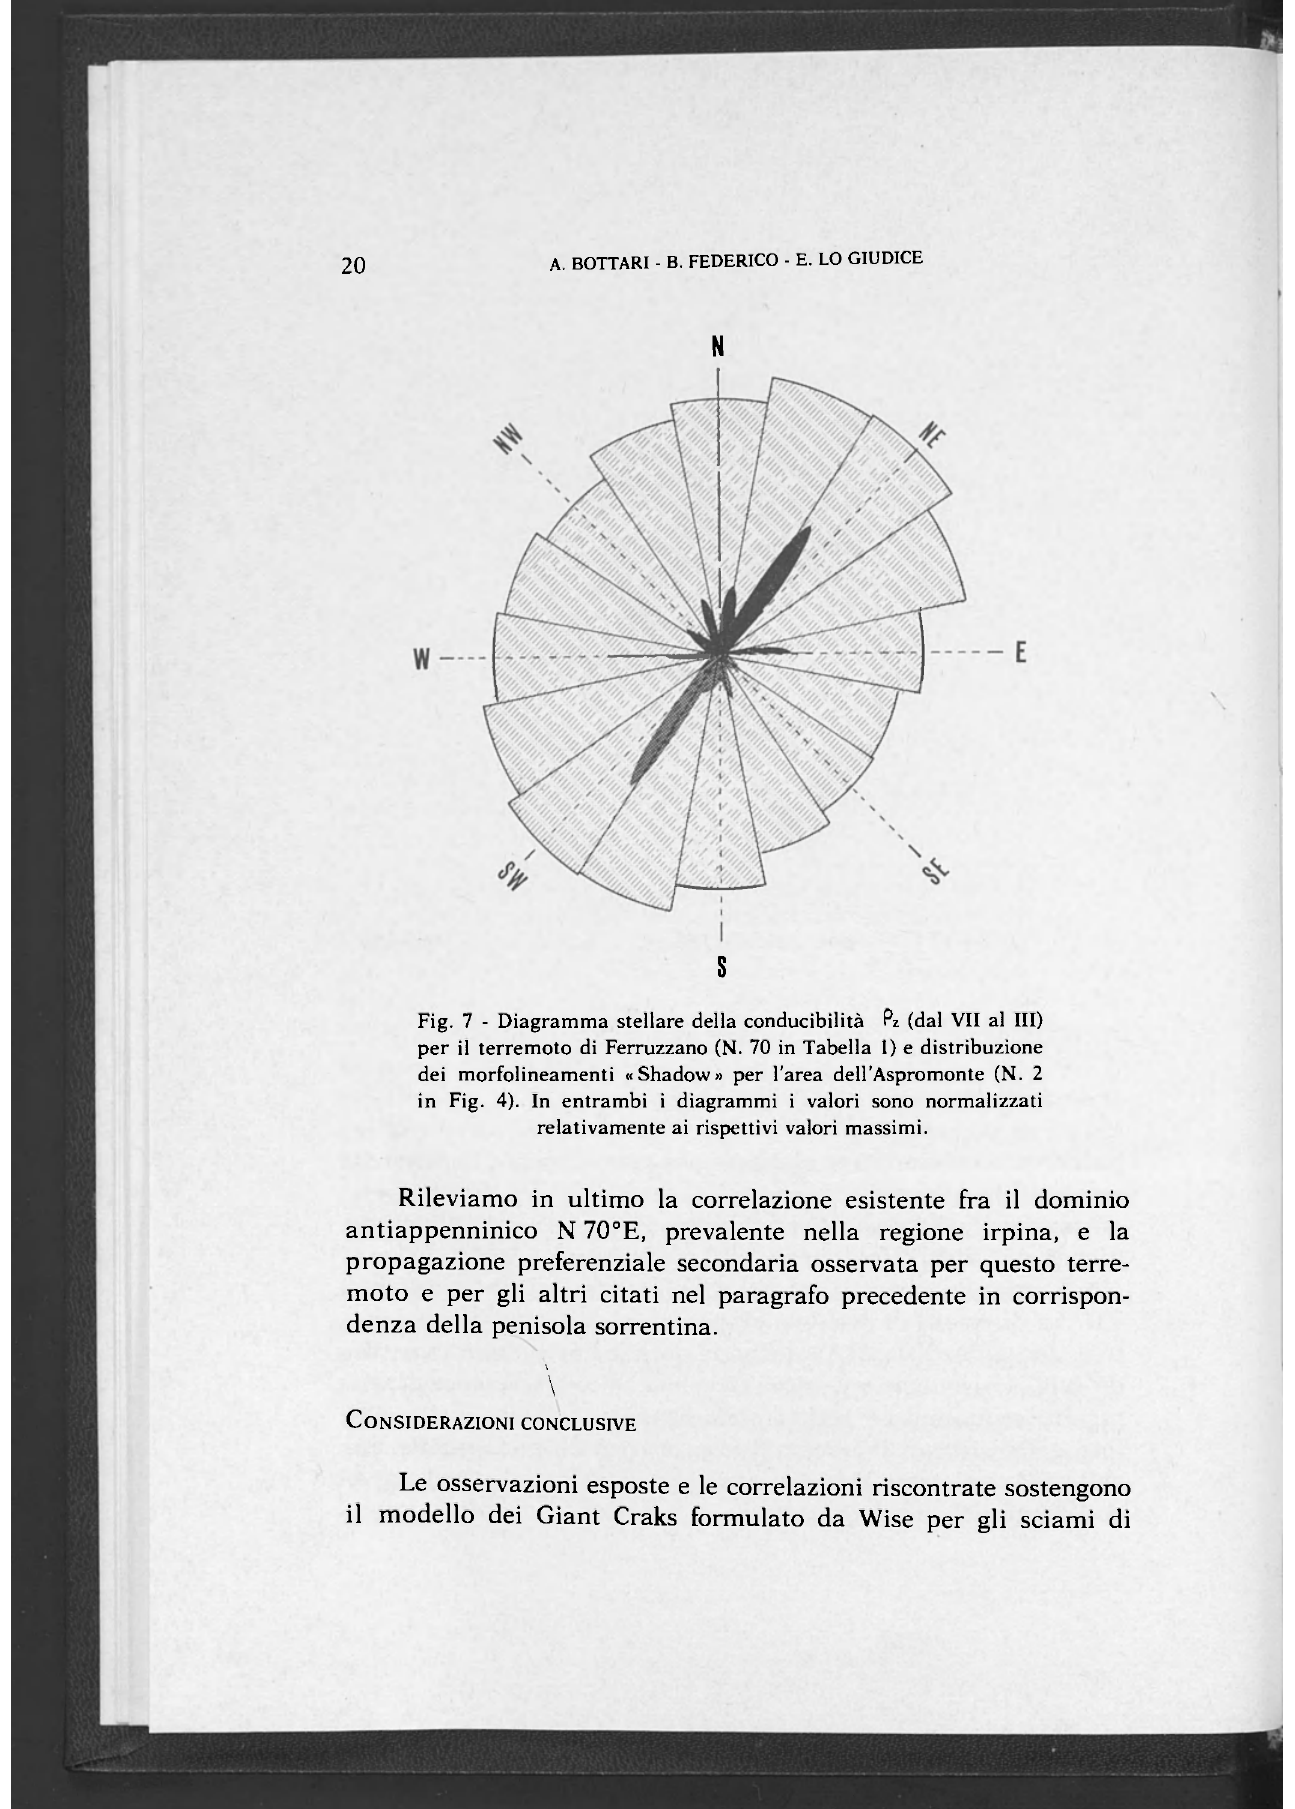
Fig. 7 - Diagramma stellare della conducibilità Pz (dal VII al III) per il terremoto di Ferruzzano (N. 70 in Tabella 1) e distribuzione dei morfolineamenti «Shadow» per l'area dell'Aspromonte (N. 2 in Fig. 4). In entrambi i diagrammi i valori sono normalizzati relativamente ai rispettivi valori